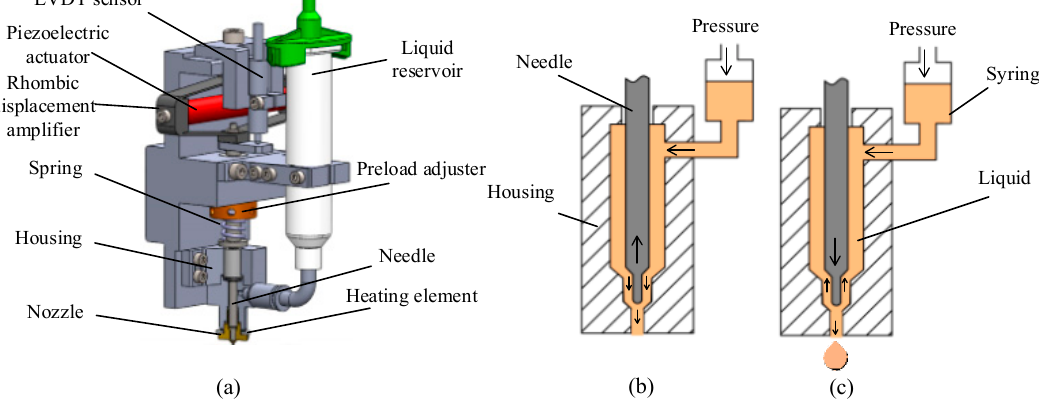
Figure 1. Dispenser configuration and working principle: ( a ) Configuration; ( b ) the needle’s upward movement process; ( c ) the needle’s downward movement process.